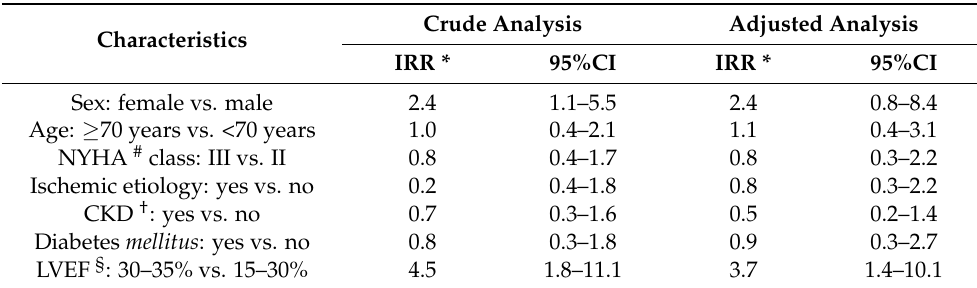
Table 2. Crude and adjusted results of the Incidence Rate Ratio of achieving an LVEF above 35% estimated by Cox regression